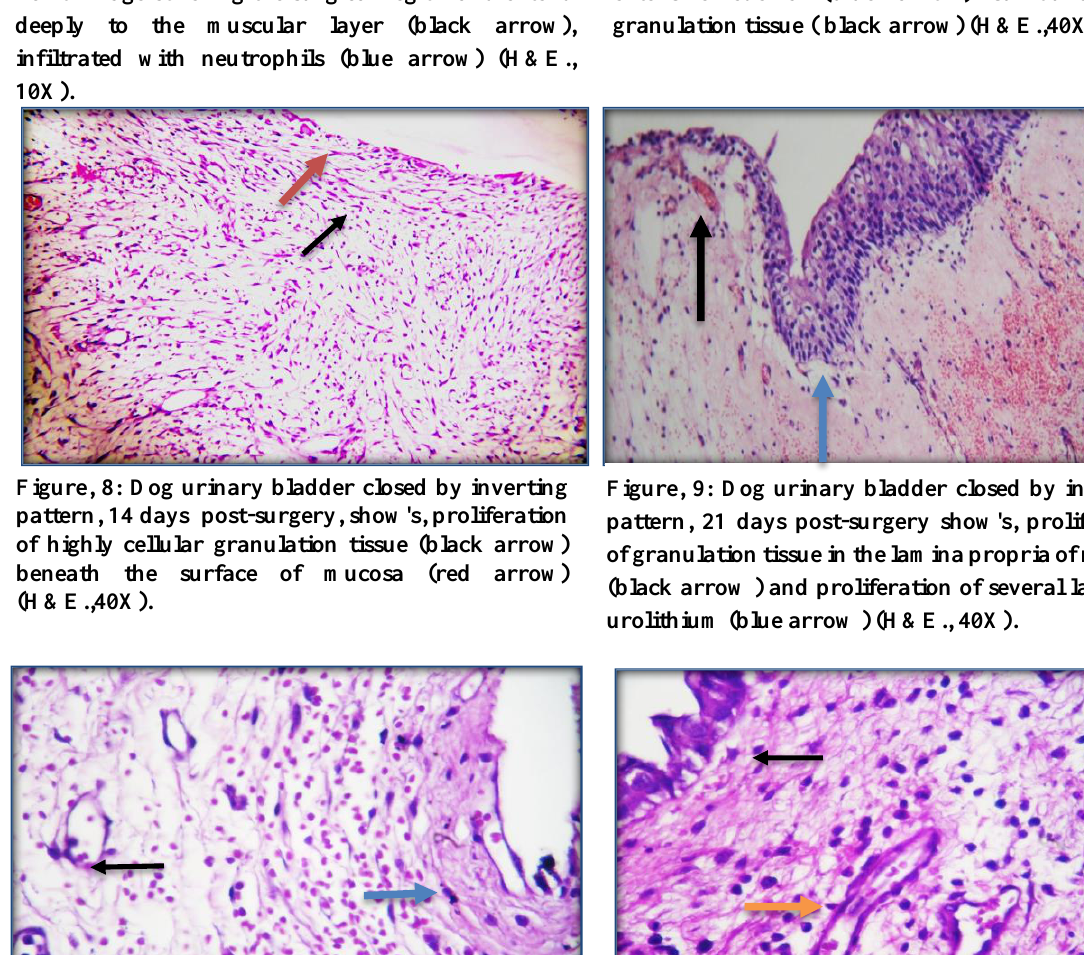
Figure, 7: Dog urinary bladder closed by inverting pattern,7 days post-operation show's, necrosis and extensive edema (blue arrow) surrounded by granulation tissue ( black arrow) (H&E.,40X).